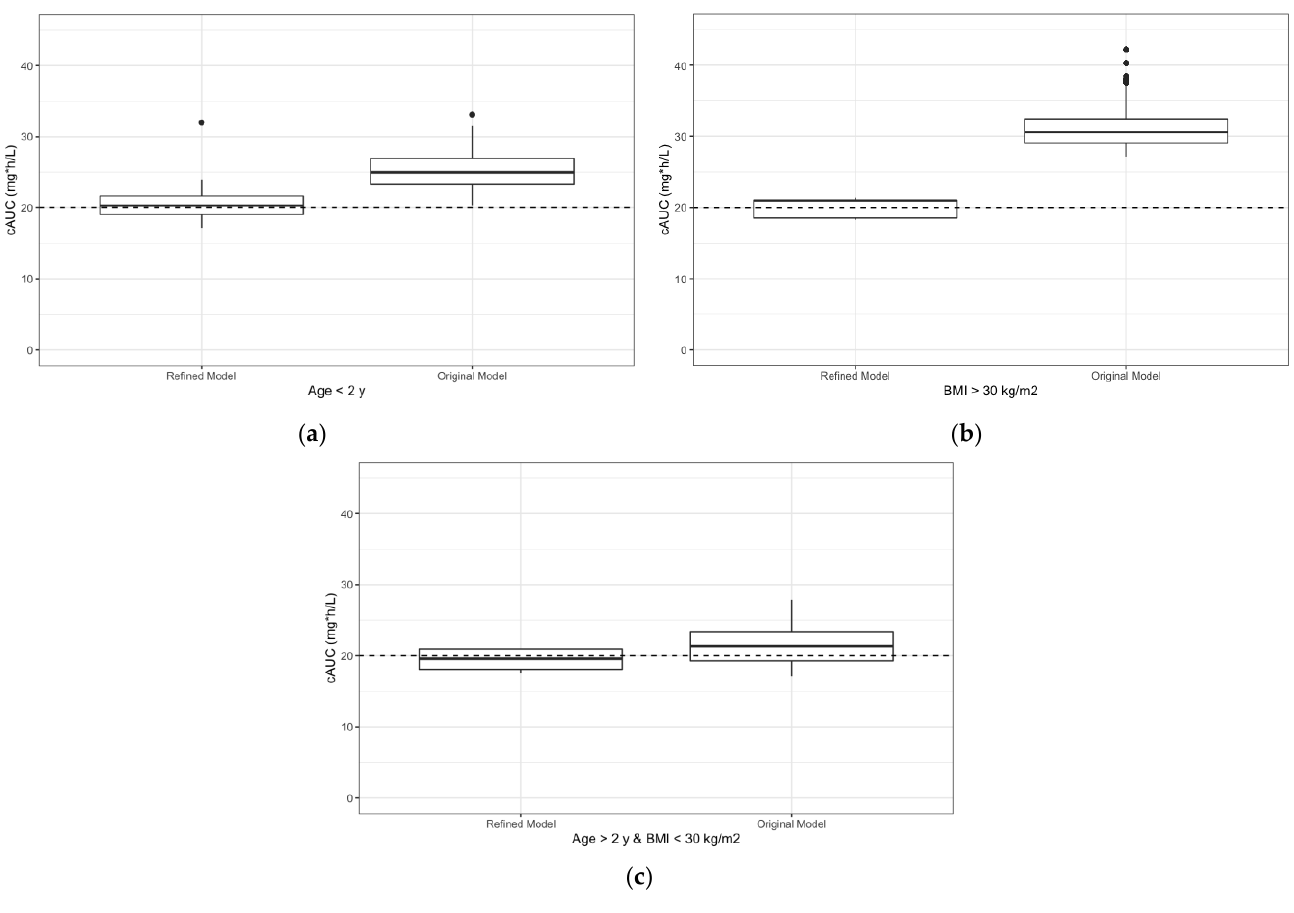
Figure 4. Simulated cAUC values to compare doses assigned by the refined model and the original model. ( a ) Predicted cAUCs of individuals less than 2 years old separated by which model was utilized to assign doses. ( b ) Predicted cAUCs of individuals with BMI greater than 30 kg/m 2 separated by model was utilized to assign doses. ( c ) Predicted cAUCs of individuals greater than 2 years old and BMI less than 30 kg/m 2 separated by model was utilized to assign